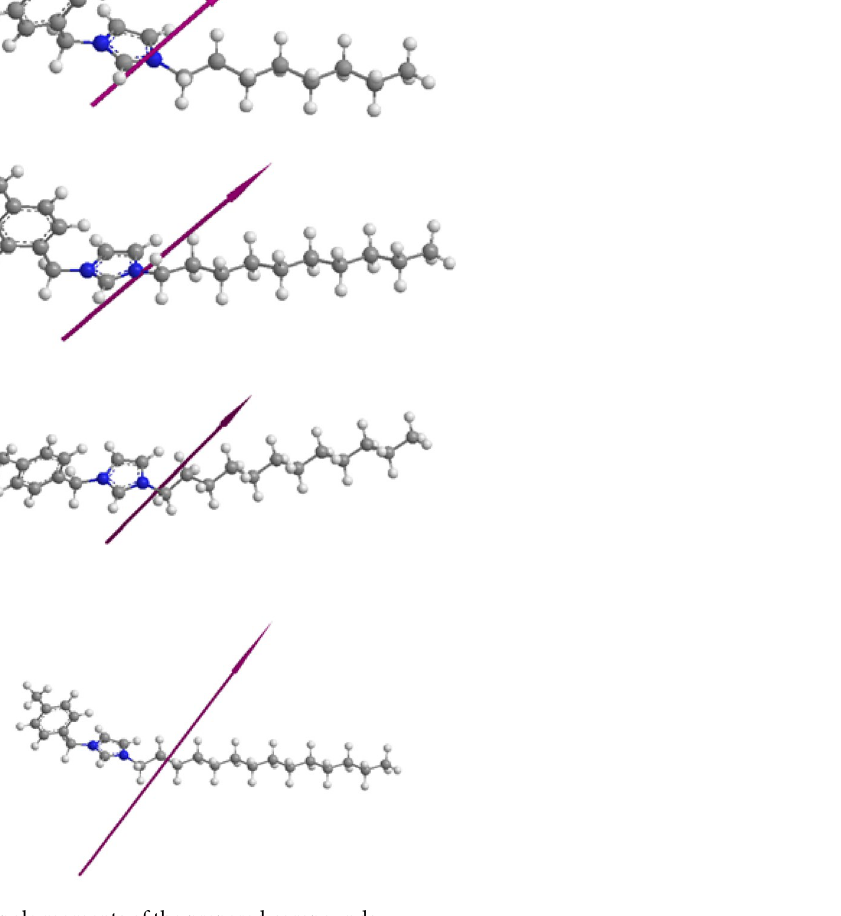
Figure 5. Dipole moments of the prepared